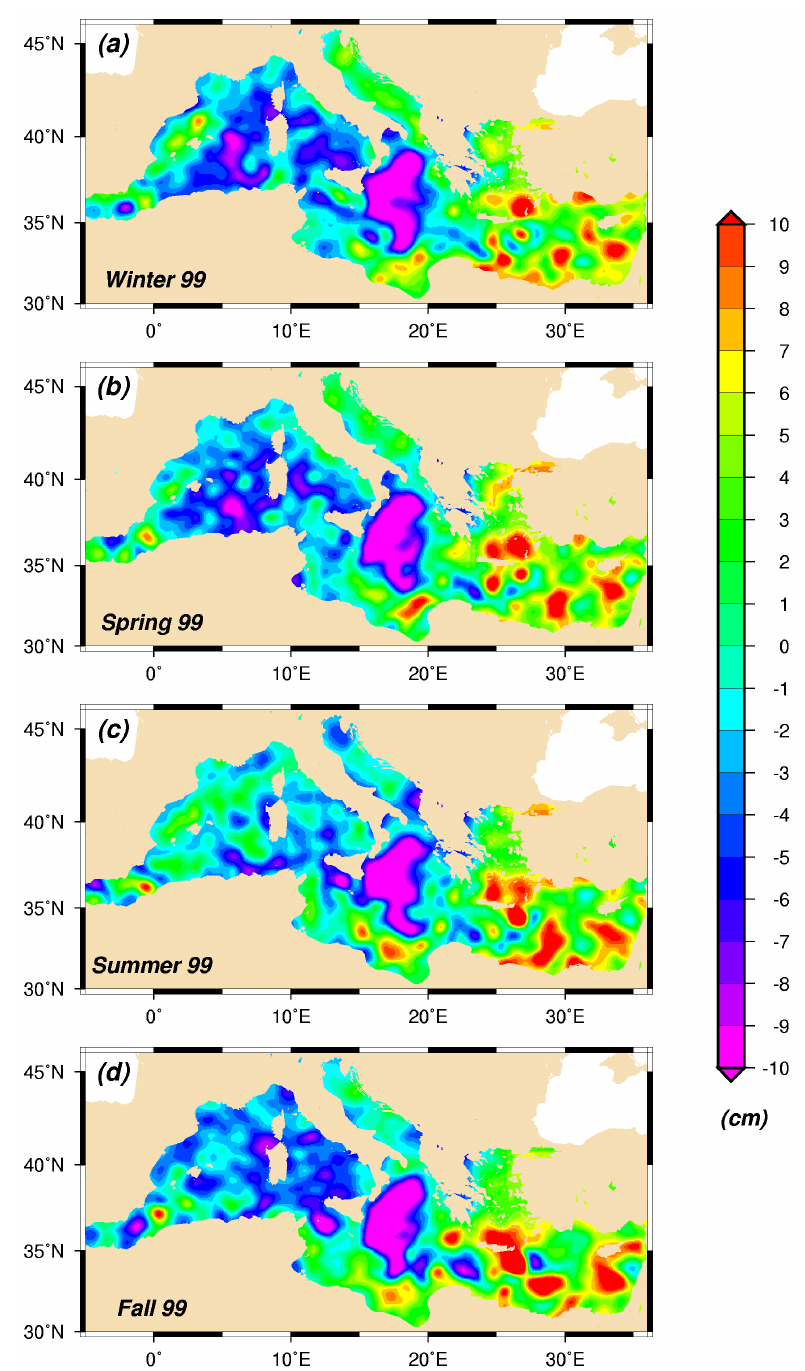
Fig. 3a. SLA seasonal means deduced from combined maps of T/P and ERS. Units are in cm. (a) Winter 1999, (b) Spring 1999, (c) Summer 1999, (d) Fall